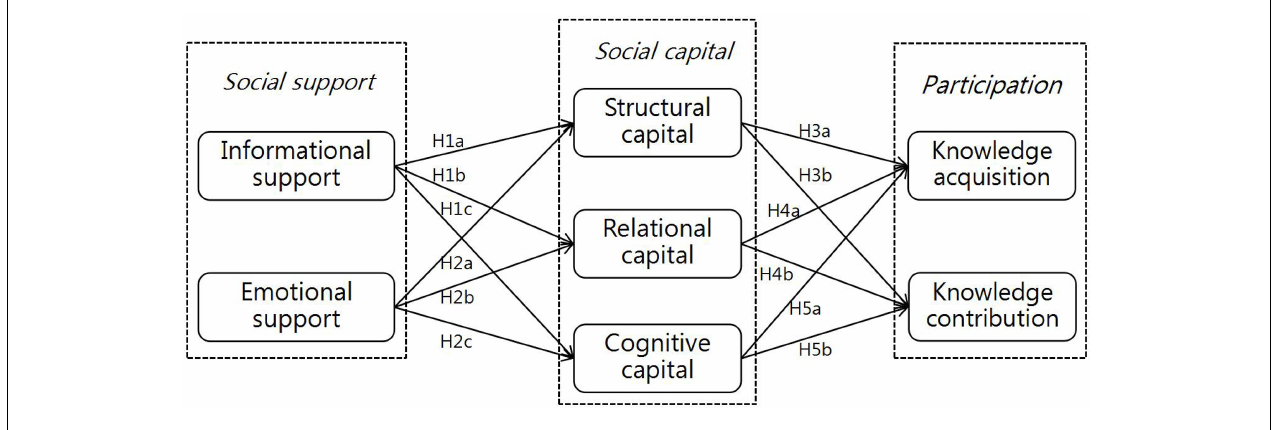
FIGURE 1 | Research